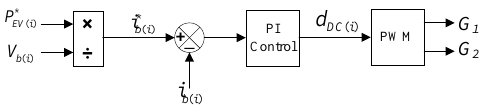
Figure 5. DC-DC converter control strategy block diagram.